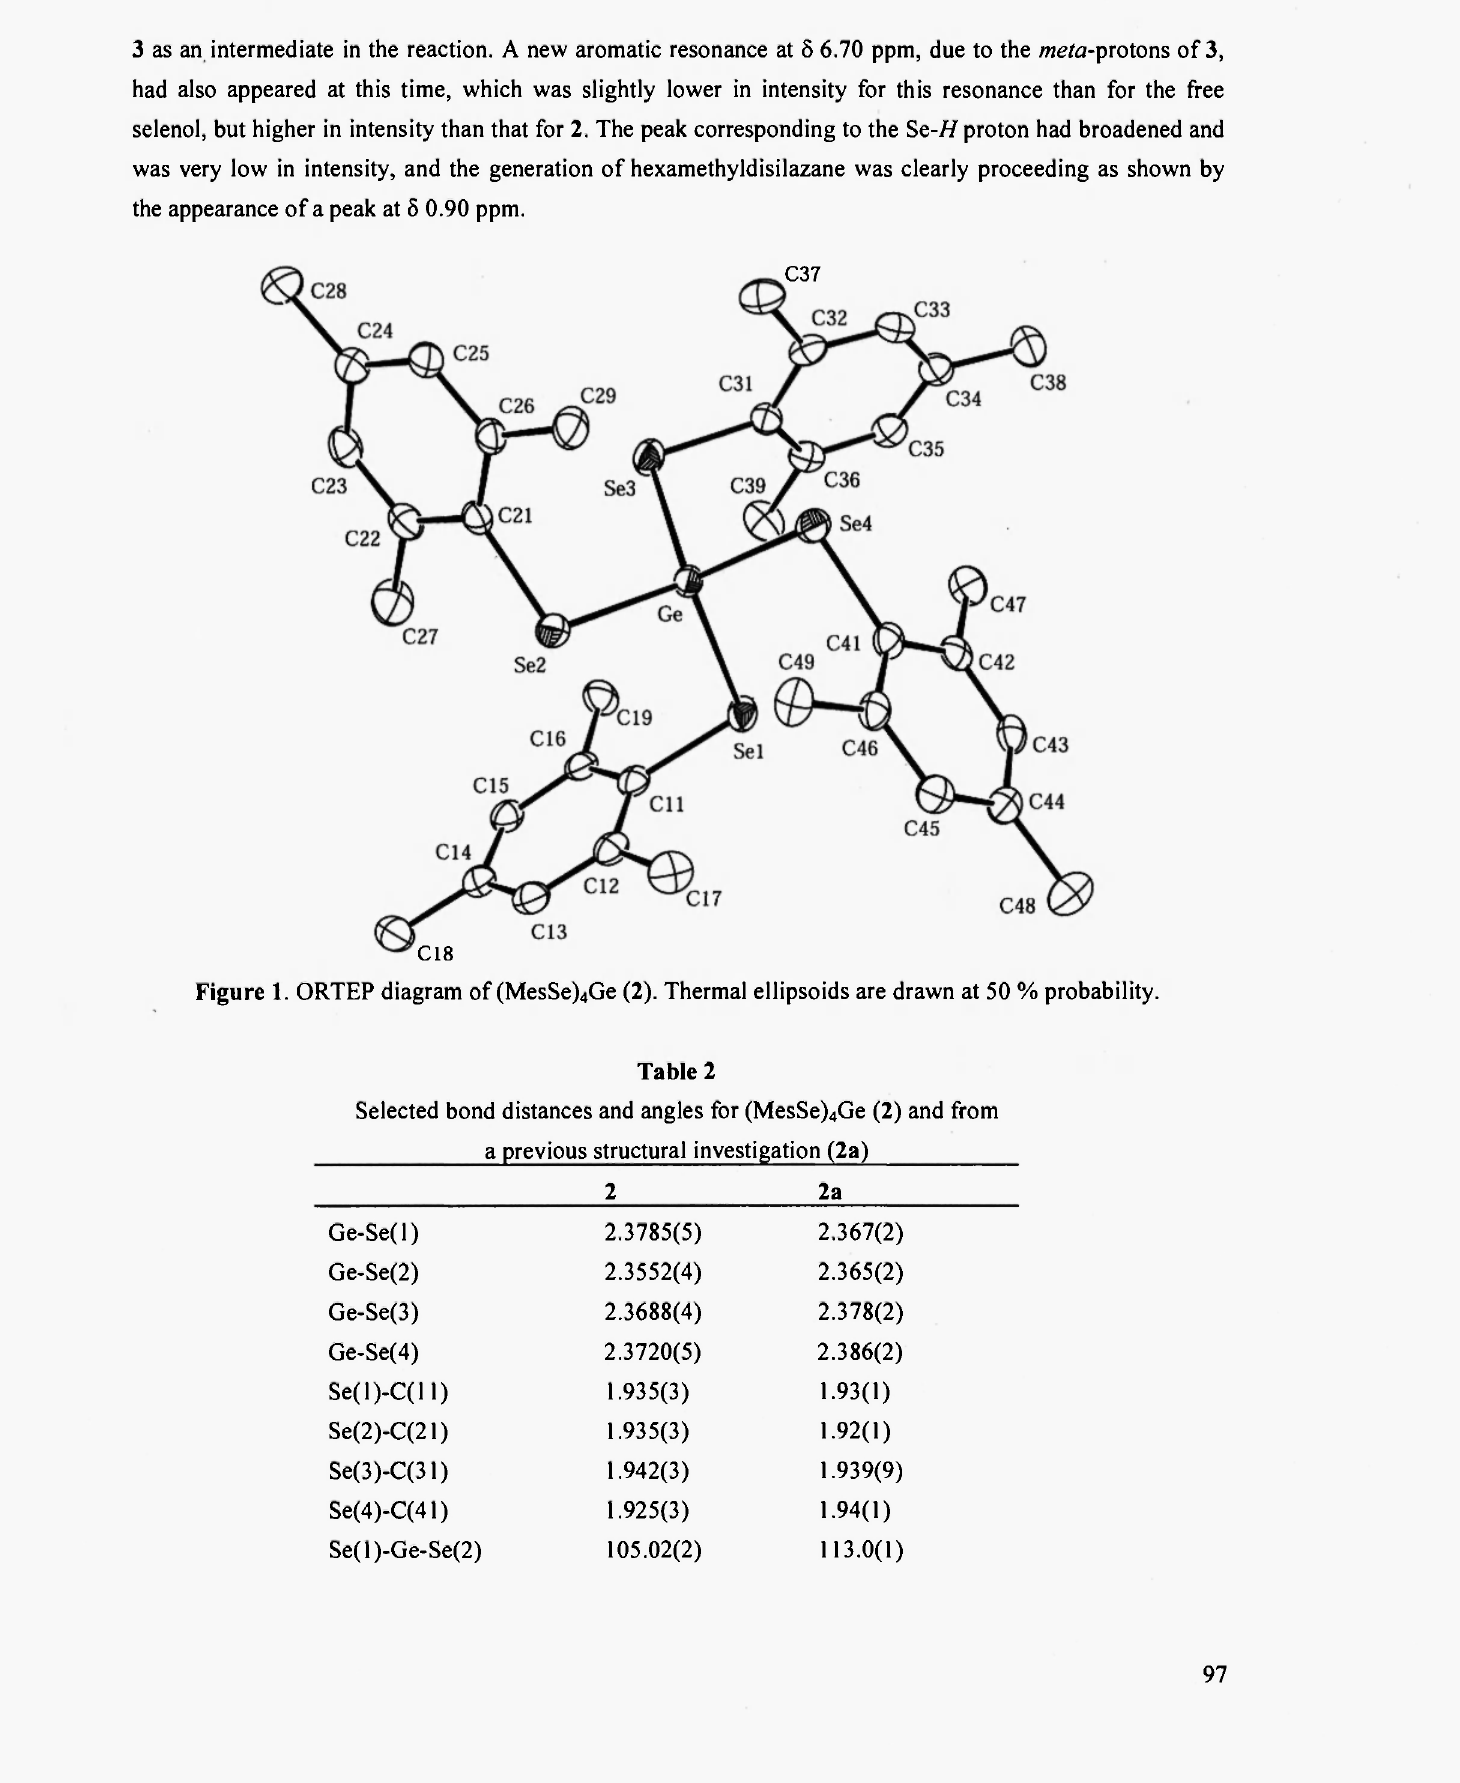
Selected bond distances and angles for (MesSe) 4 Ge (2) and from a previous structural investigation